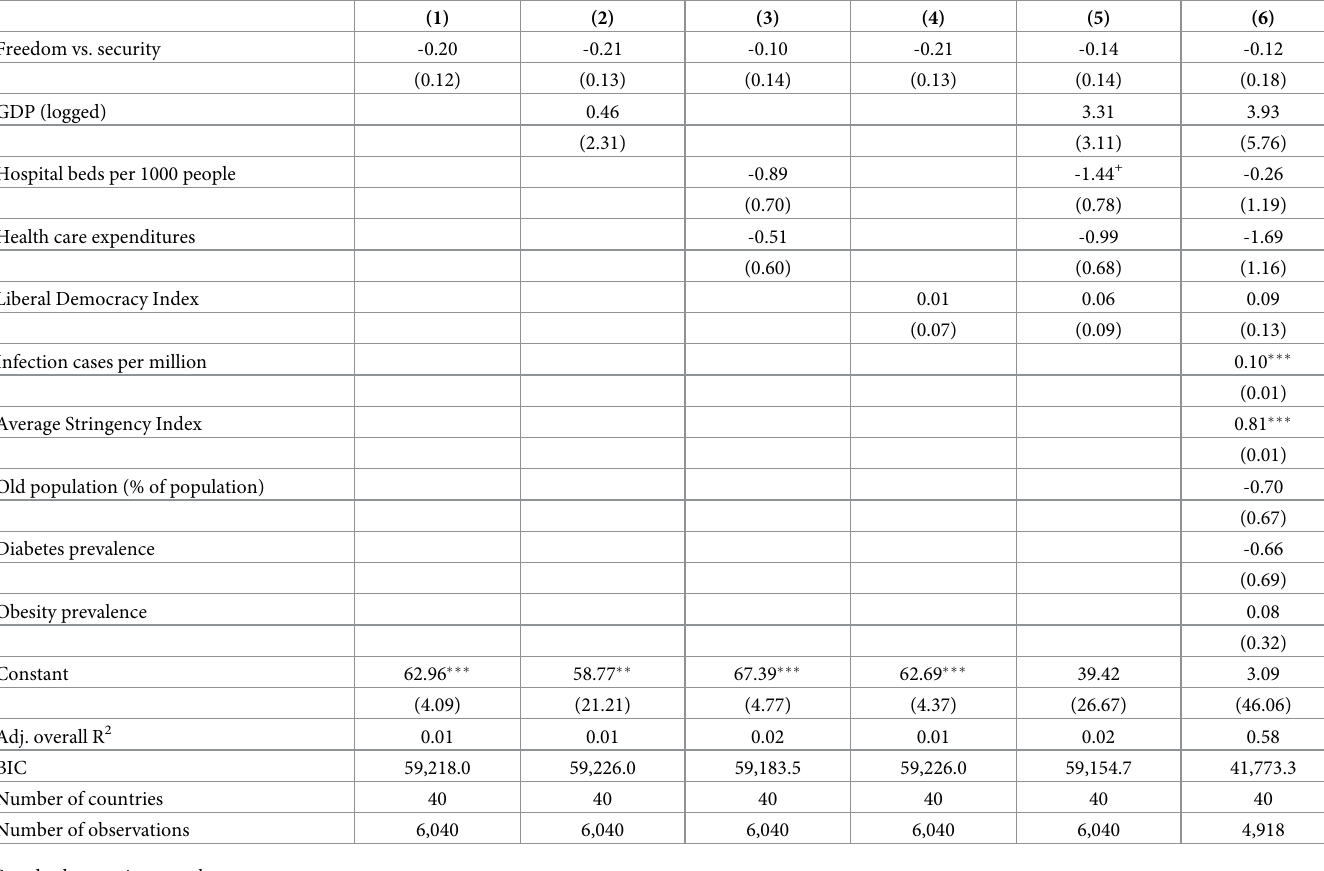
Table 2. Random effects models for the Stringency Index, all countries (n =